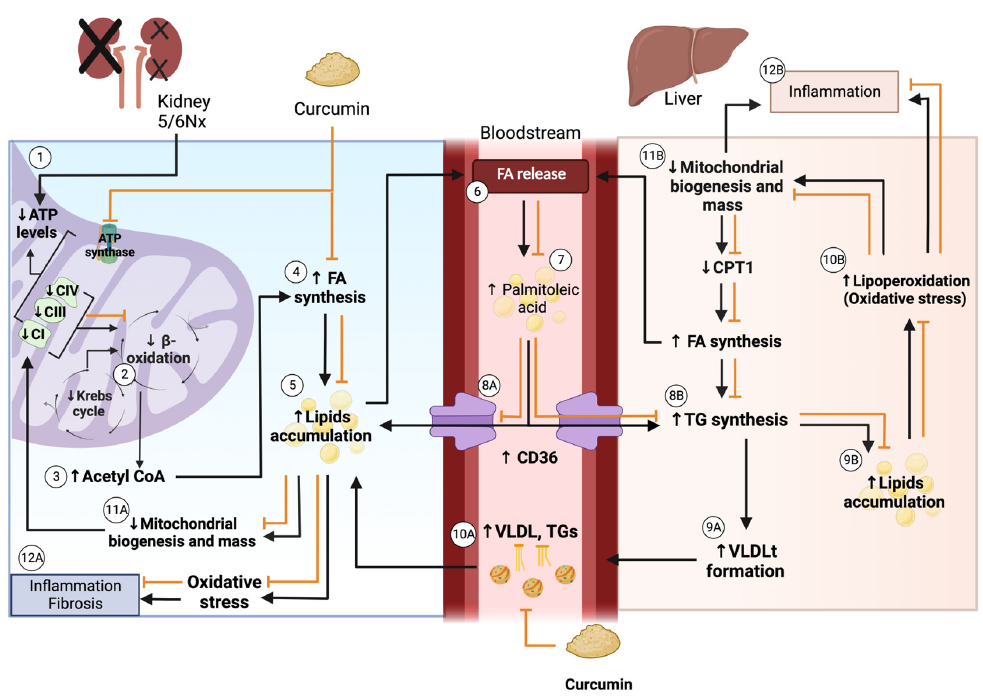
Figure 10. Integrative scheme. (1) In kidney of 5/6 nephrectomy (5/6Nx), adenosine triphosphate (ATP) levels are reduced, attributed to the decrease in the activity of electron transfer system (ETS) elements complex I (CI), CIII, and CIV, and ATP synthase [34]. (2) The decrease in the ETS reduces β -oxidation [18], which along with the reduction in the Krebs cycle, leads to (3) acetyl CoA accumulation [60]. This acetyl CoA is used for (4) fatty acids (FA) synthesis, inducing (5) lipid accumulation, and latter (6) FA release into the bloodstream, particularly (7) palmitoleic acid, which increases in the bloodstream and might (8A) reenter the kidney via a cluster of differentiation 36 (CD36), contributing to lipid accumulation [9]. On the other hand, palmitoleic acid might (8B) enter the liver by CD36, increasing triglycerides (TG) synthesis. TG synthesis increases (9A) the formation of VLDLt, or (9B) contributes to lipid accumulation in the liver. VLDLt proteins (10A) might be delivered in the bloodstream, which increases VLDL and TG levels that could go to the kidney and reinforce lipid accumulation. In the kidney, lipid accumulation (11A) decreases mitochondrial biogenesis and mass, decreasing ETS proteins. Besides, (9B) lipid accumulation in the liver promotes (10B) oxidative stress by inducing lipoperoxidation, which (11B) reduces mitochondrial biogenesis and mass, inducing the decrease in carnitine palmitoyl transferase 1 (CPT1), and later, the increase in FA synthesis, which also induces FA releasing into the bloodstream. Oxidative stress and the reduction in biogenesis and mass contribute to inflammation and fibrotic process (12A) in the kidney and (12B) liver. Curcumin increases the ETS system and β -oxidation in the kidney. It also decreases FA synthesis in the kidney and the liver and these processes could prevent lipid accumulation and, in consequence, the release of significant amounts of FA into the bloodstream. Besides, curcumin decreases CD36 in the kidney and the liver (5/6Nx group), which diminishes FA uptake and lipogenesis in the liver. This could prevent lipoprotein (VLDL) formation in the liver, which was reflected in its bloodstream concentrations that were decreased by curcumin. Thus, curcumin improves mitochondrial function, preventing